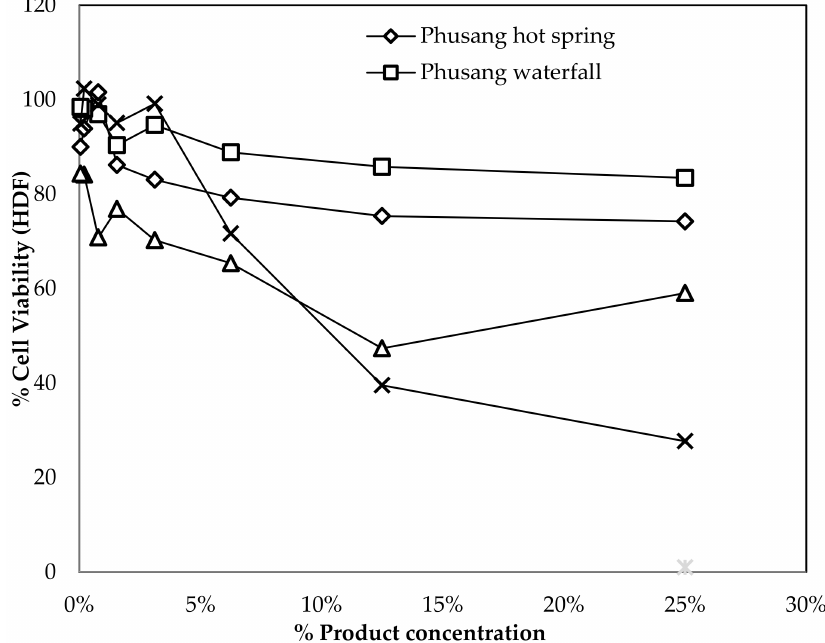
Figure 5. Effects of different concentrations of Phusang hot spring water, Phusang waterfall water and Phusang hot spring powder on the viability of HDFa cells at 24 h, as determined using MTT